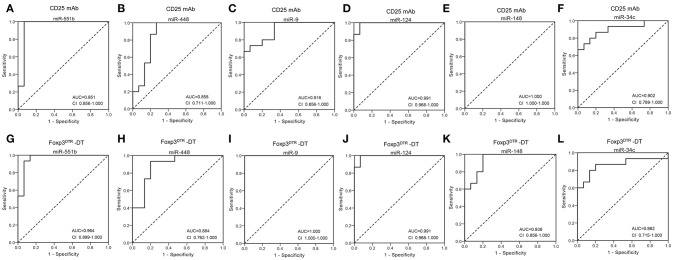
Diagnostic value of selected serum miRNAs. (A–F) ROC curve for the ability of individual miRNAs (miR-551b, miR-448, miR-9, miR-124, miR-148, and miR-34c) to separate CD25 mAb mice from controls. (G–L) ROC curve for the ability of miR-551b, miR-448, miR-9, miR-124, miR-148, and miR-34c to separate Foxp3DTR –DT mice from controls.